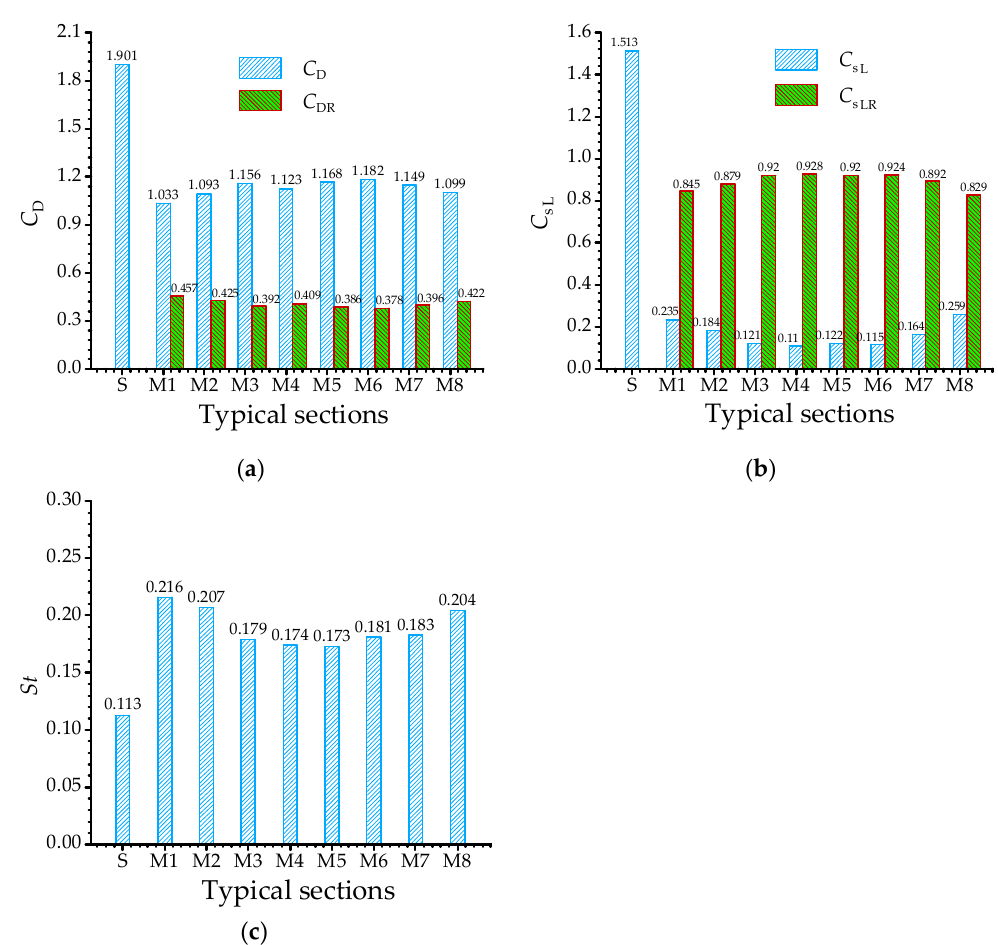
Figure 9. Aerodynamic force coefficients and Strouhal number of the benchmark section and the sections M1~M8: ( a ) C D and C DR , ( b ) C sL and C sLR , and ( c ) St .